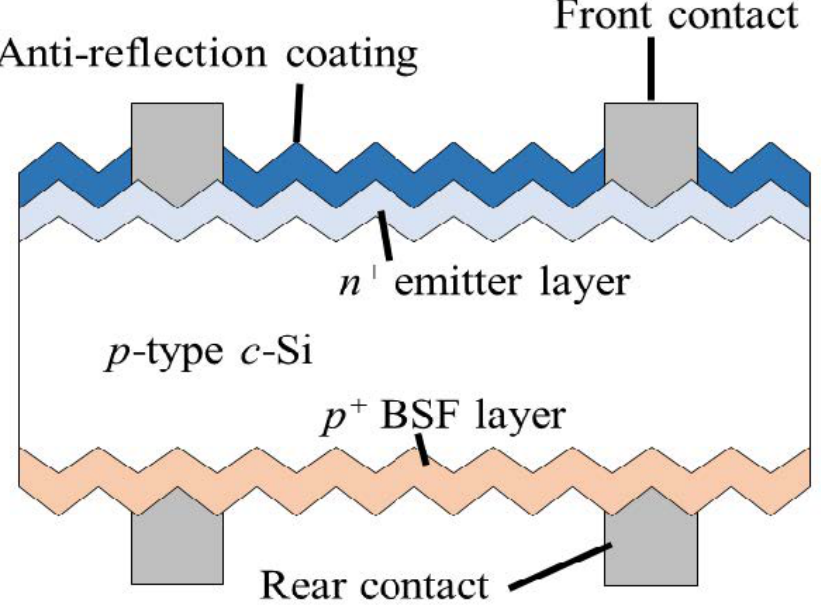
Figure 2. Silicon solar cell structure used for this